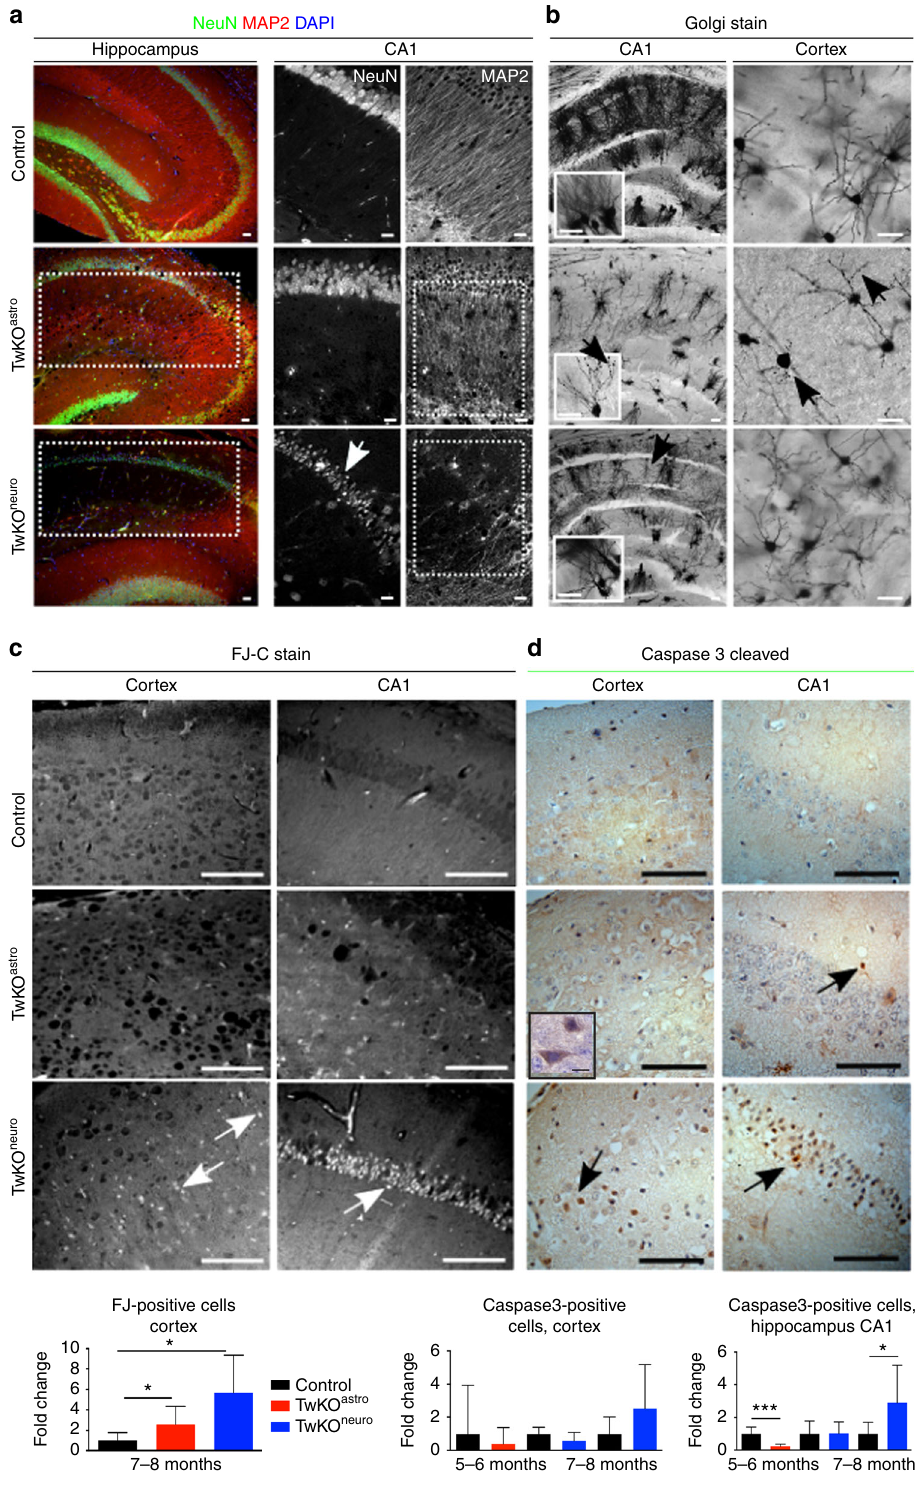
Fig. 5 MtDNA loss in astrocytes or neurons challenges neuronal dendrite maintenance and causes neurodegeneration. a Immuno fl uorescent co-staining (overlay) of neuronal nuclei (NeuN, green), dendrites (microtubular MAP2, red) and nucleus (DAPI, blue) in hippocampus of 7 – 8 months old mice. b Neuronal fi ne morphology with Golgi staining in 7 – 8 months old mice. Arrows point gross morphological changes with dendritic degeneration in both KOs and varicosities in TwKO astro . c Dying neurons (arrows), Fluorojade-C (FJ-C) staining. Quanti fi cation below. d Apoptotic cells (arrows); immunohistochemical staining for cleaved caspase-3 and counterstaining with hematoxylin (parallel sections to FJ-C ( c )). Quanti fi cation in somatosensory cortex and CA1 region of hippocampus below. Inset: enlarged caspase-3-positive cell. The data are presented as mean and error bars indicate standard deviation. Statistical signi fi cance: * p < 0.05, ** p < 0.01, *** p < 0.001. Scale bars: 20 μ m ( a , b ), 50 μ m ( c , d